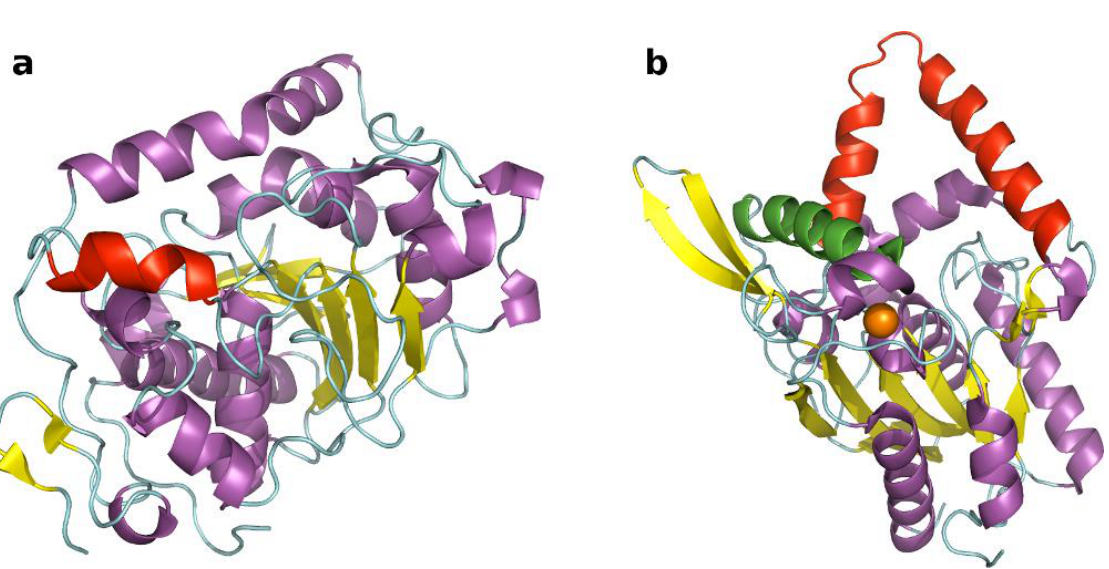
Figure 1. Tridimensional models of CaLB ( a ) (PDB code 1TCA) and PcL ( b ) (PDB code 1YS1). The structures are colored according to their secondary structures; lids are highlighted in red. PcL ( b ) has the second “putative” lid highlighted in green and the Ca 2+ ion represented as orange